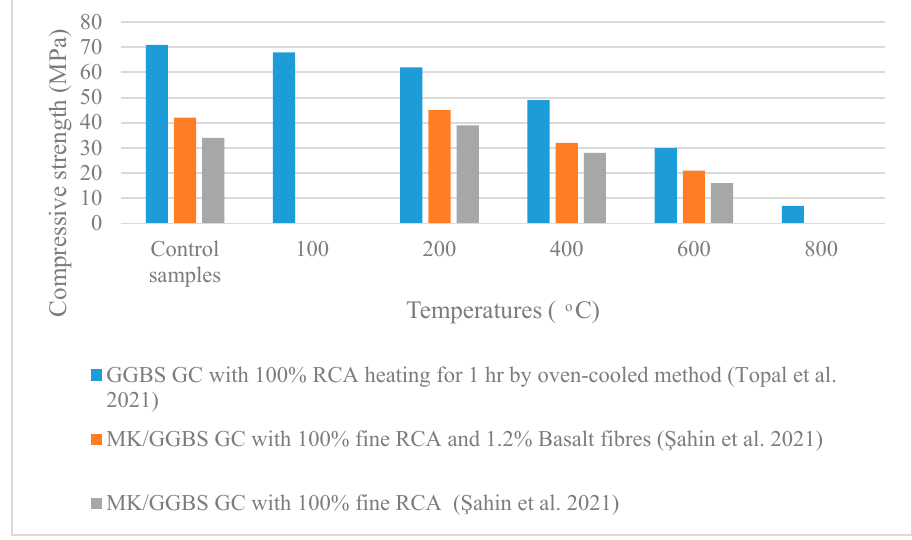
Figure 9. Relationship between heating temperature and CS [70,111].